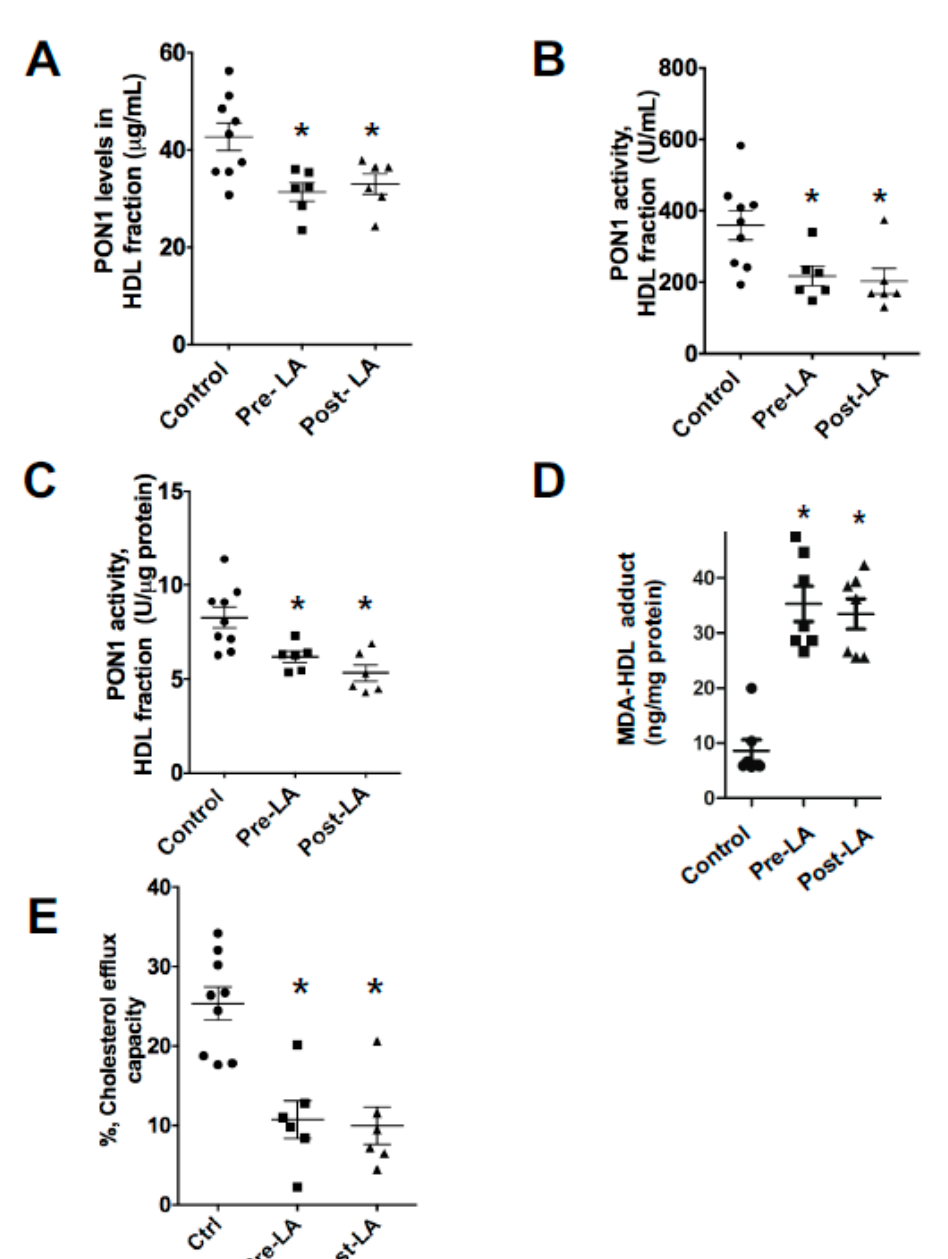
Figure 5. FH patients have decreased PON1 activity, increased MDA-apoAI adducts, and defective HDL cholesterol e ffl ux capacity. The PON1 levels were determined in the ApoB-depleted serum fraction ( A ) from normal controls ( n = 9) and FH ( n = 6) subjects pre- and post-LDL apheresis. The PON1 activity was determined in ApoB-depleted serum fraction ( B ) and the specific activity of PON1 in control and FH subjects is shown ( C ). HDL-MDA content ( D ) and cholesterol e ffl ux capacity ( E ) were determined in control versus FH subjects. The PON1 activity assay was performed using the EnzCheck PON1 activity kit, which measures the organophosphatase activity of PON1. PON1 standards and diluted human serum samples were prepared in TSC bu ff er. The samples and standards were then incubated for 30 min with TSC bu ff er containing 100 µ M substrate. Fluorescence intensity was then measured using Biotek’s Synergy MX Microplate reader after 30 min of incubation at 37 ◦ C. Graphs represent data (mean ± SEM) of the experiments; * p < 0.05 is indicated by comparison of control group with the indicated group using one way